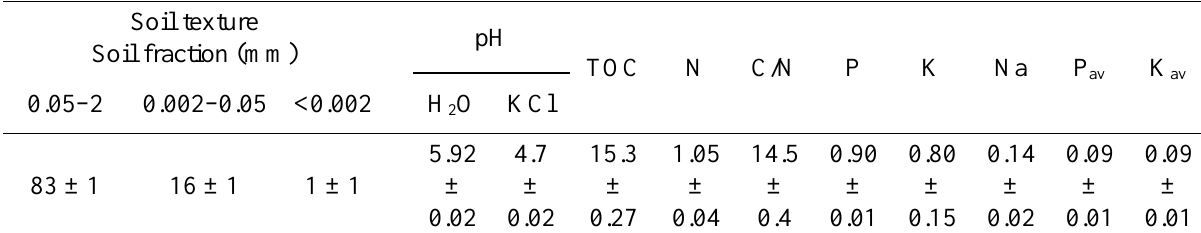
Table 1. Basic properties of the soil used in the incubation experiment (mean value ± standard deviation ( n =3)). Soil texture = content of soil fraction (%); pH = reaction; TOC = total organic carbon (g kg -1 ); N = total nitrogen content (g kg -1 ); P = total phosphorus content (g kg -1 ); K = total potassium content (g kg -1 ); Na = total sodium content (g kg -1 ); P av = plant-available phosphorus (g kg -1 ); K av = plant-available potassium (g kg -1